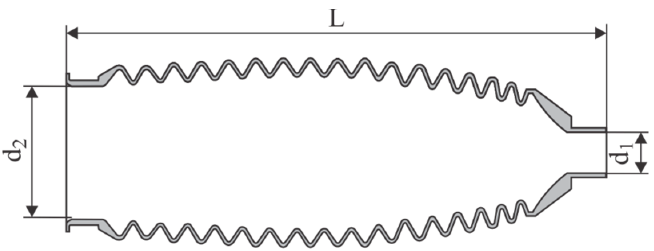
Figure 5. The schematic presentation of a cuff with characteristic measurements.